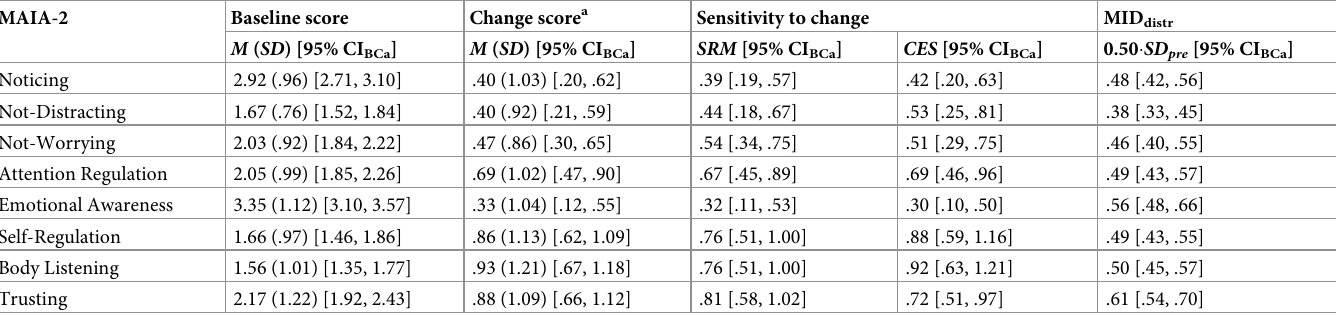
Table 5. Sensitivity to change and distribution-based minimal important differences of the MAIA-2 scales ( n = 87).